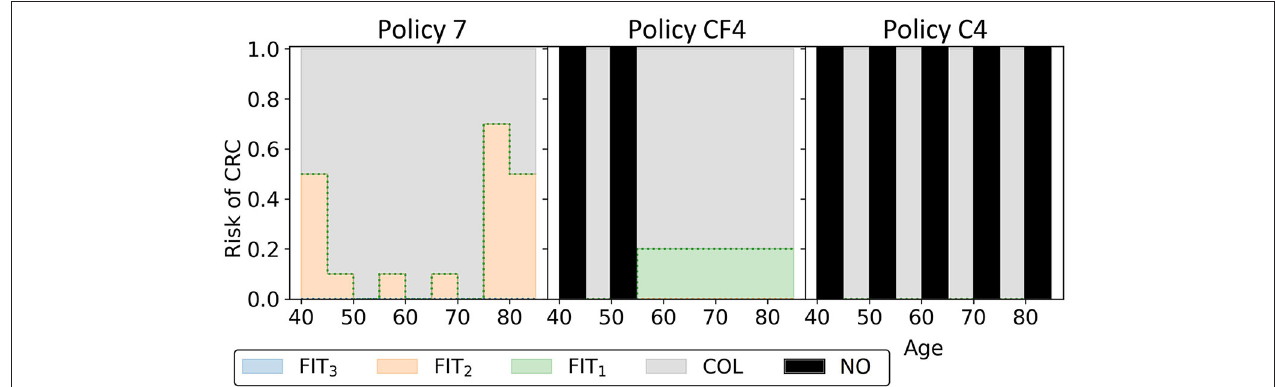
FIGURE 14 | The three black-orange/green-orange policies in Figure 10 are shown. Policy 7 is the cost-effective policy within the willingness-to-pay threshold in the approximation set for Experiment 3. Policies CF4 and C4 are the closest reference policies in terms of costs and QALYs (see also Supplementary Table 3 ). For age groups with a black bar, no screening is